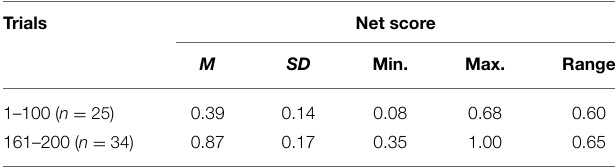
TABLE 3 | Mean net scores (expressed as proportions of number of trials) and variability statistics in participants who developed stable preferences for the good decks (C and/or D) in the present